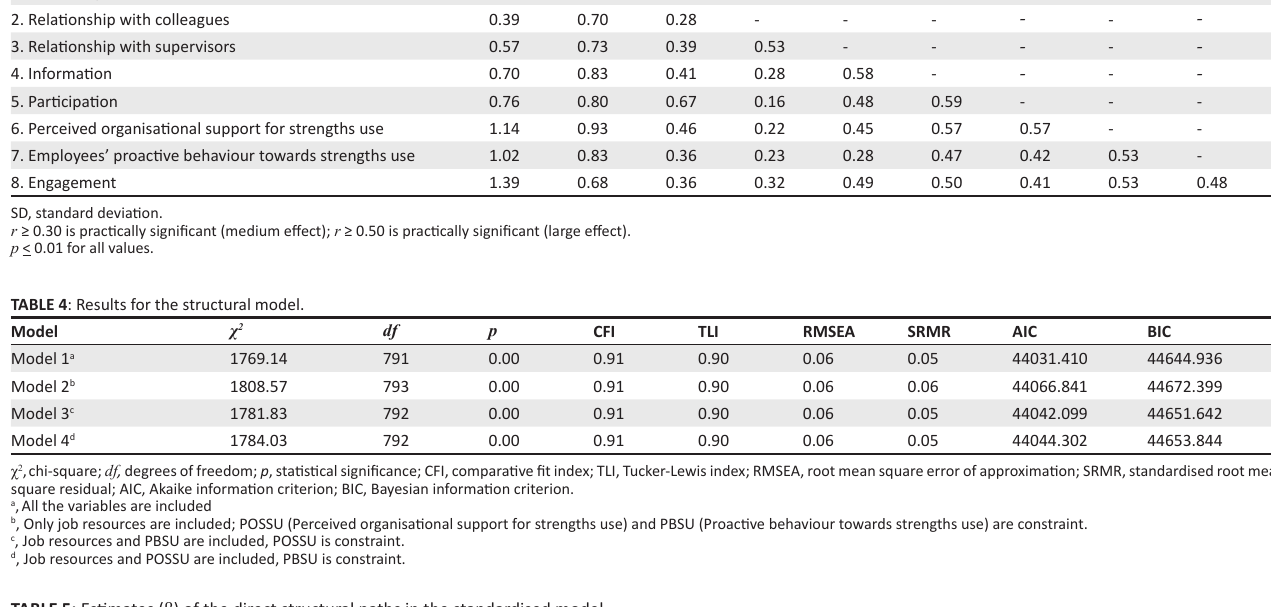
TABLE 5: Estimates ( β ) of the direct structural paths in the standardised model. Structural